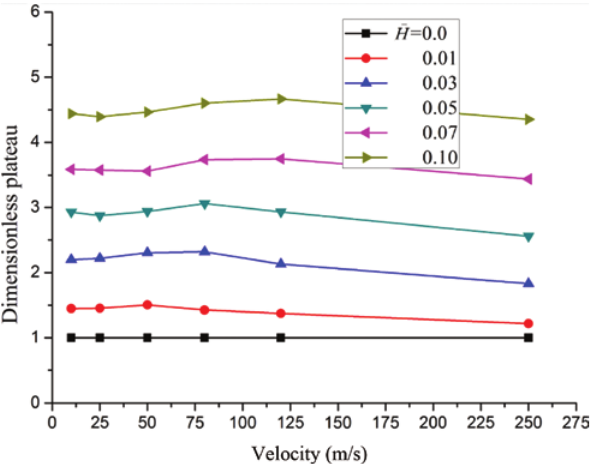
Figure 10: Dimensionless plateau stress at the stationary